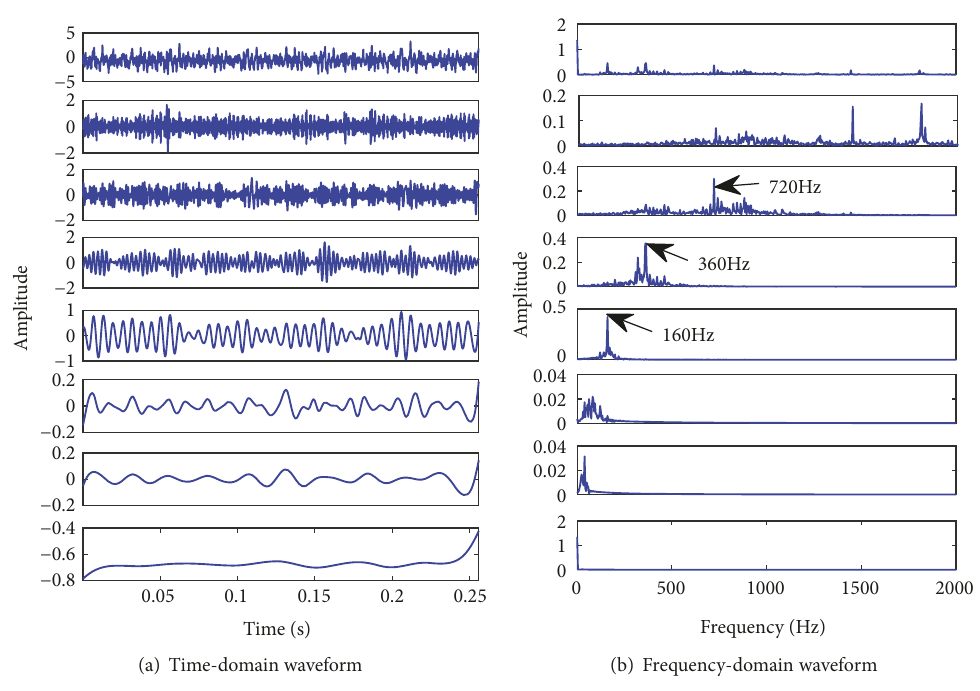
Figure 19: Decomposition results of measured signals obtained by CELMD. Table 6: Bearing